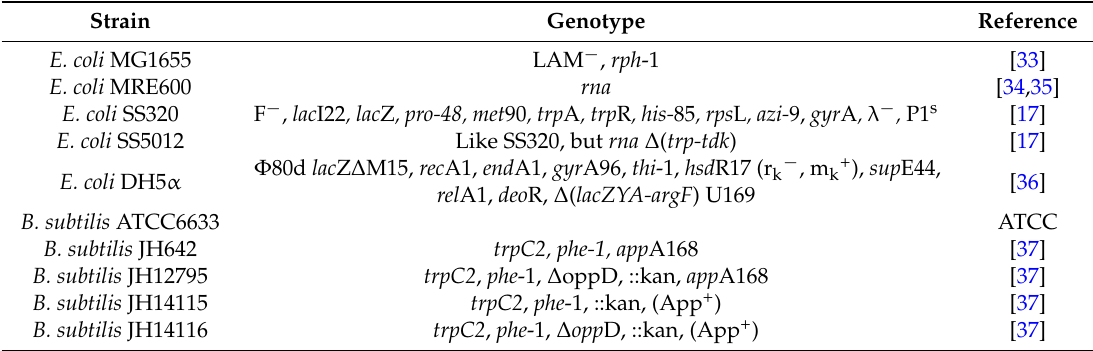
Table 6. Bacterial strains used in this